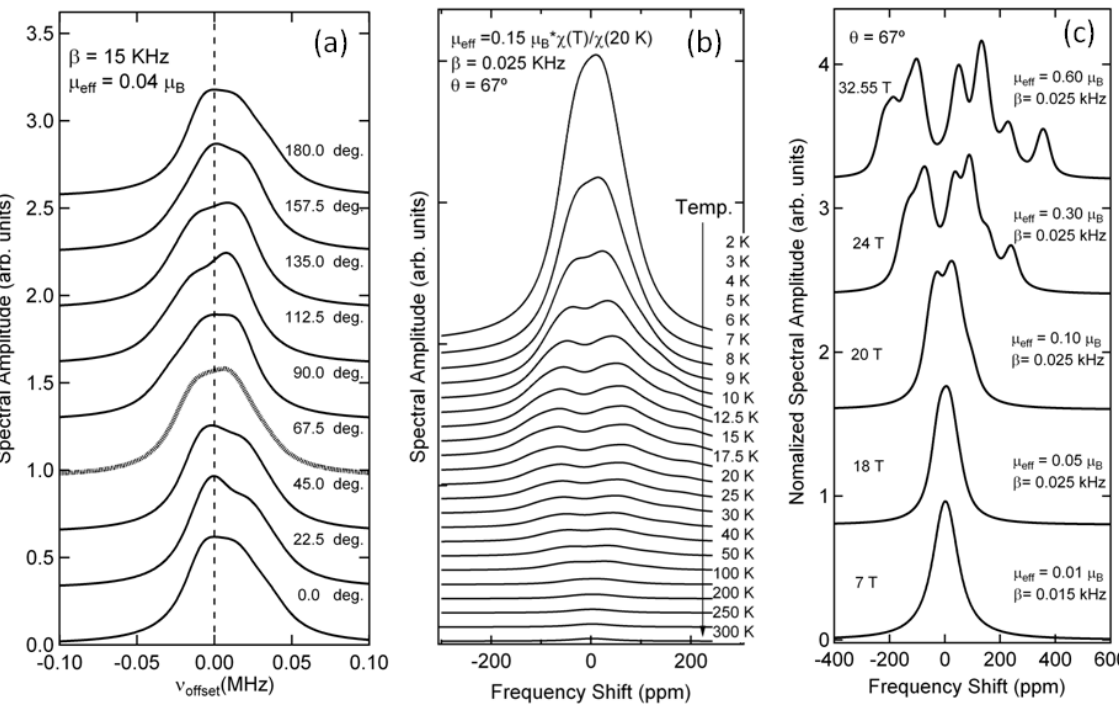
Figure 7. Computed 1 H spectra (traces offset for clarity) from Equation (4) for single crystal Per [Pt(mnt) ] vs . ( a ) field direction; 2 2